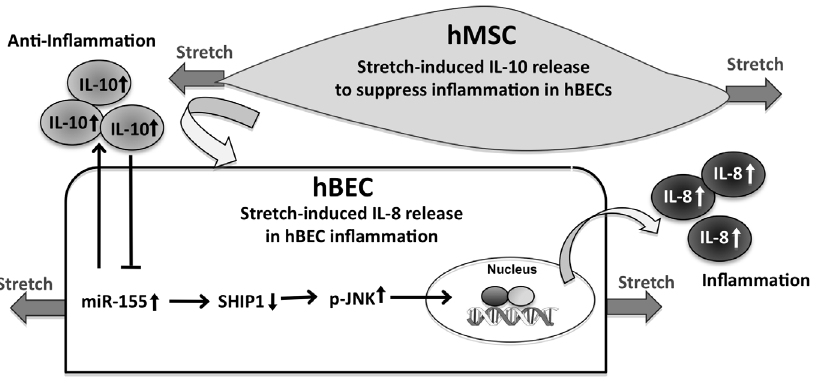
Figure 8. Schematic representation of the role of hyperstretch and hMSC in pulmonary cell inflammation. Hyperstretch induces miR- 155 to target SHIP1, which leads to the increases of JNK activation and consequential IL-8 secretion. Co-culture of hMSCs exhibits the anti- inflammation effects to reverse the hyperstretch-induced hBEC inflammatory responses.